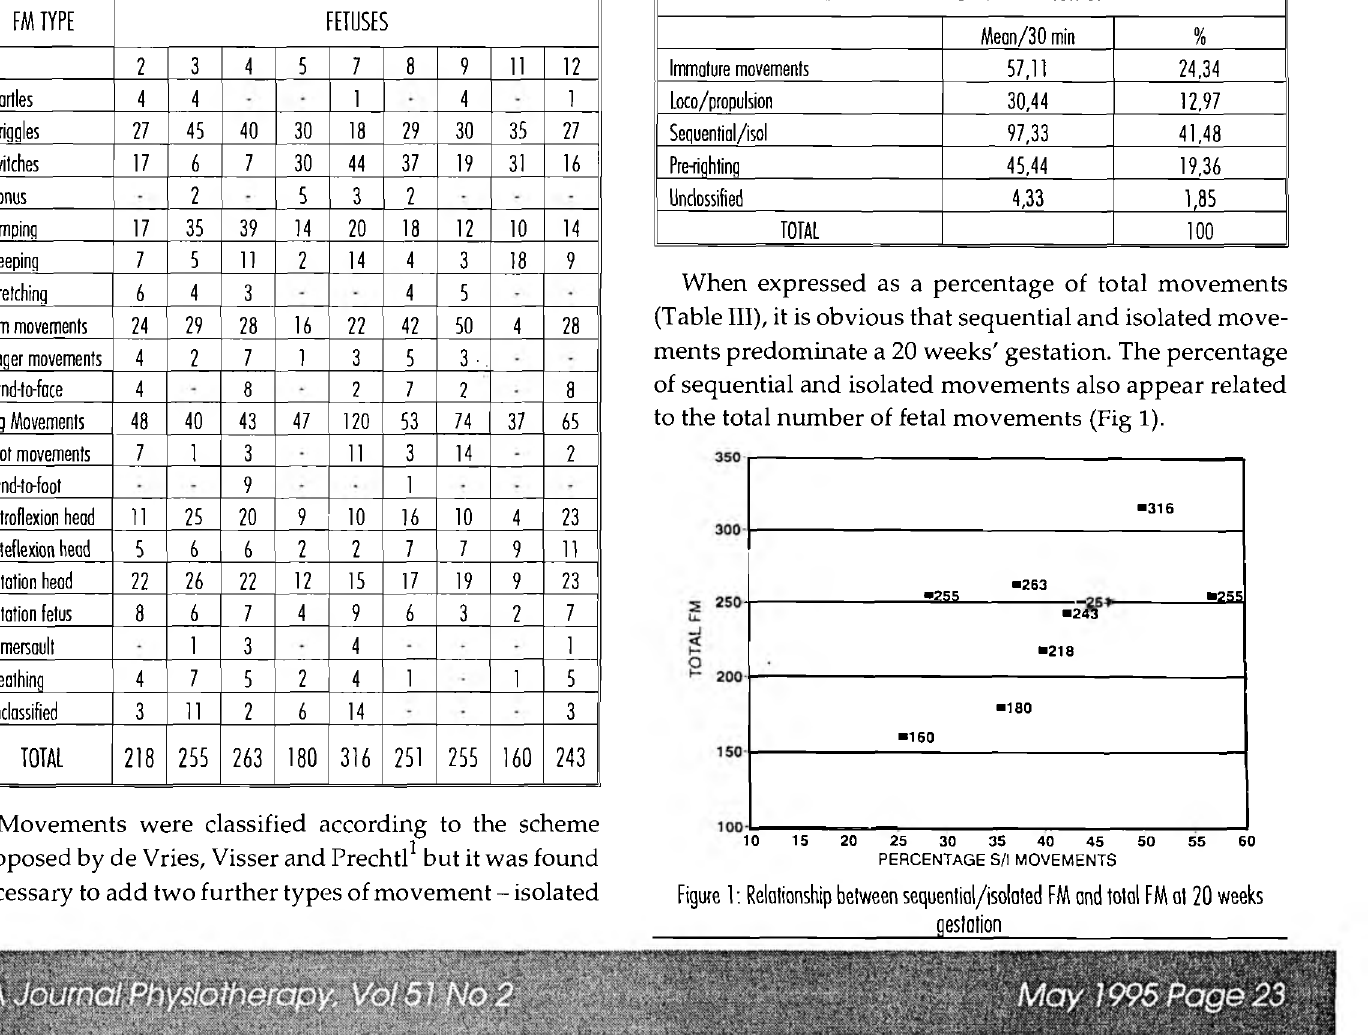
TABLE III: FM TYPE AS A PROPORTION OF FM